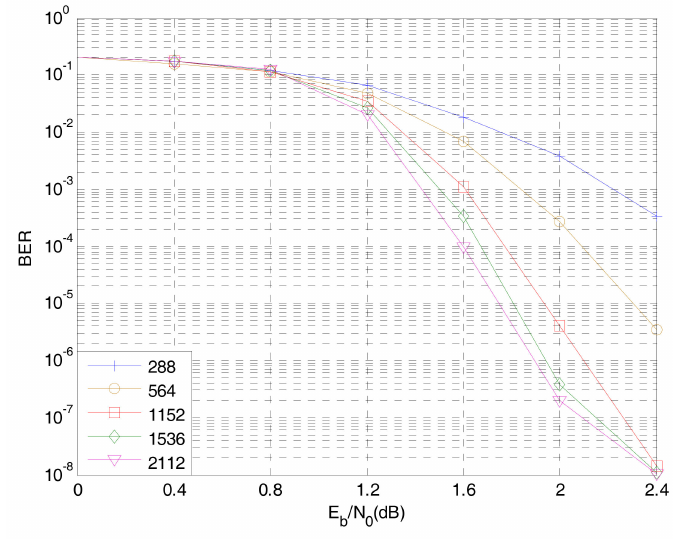
Figure 10. The influence of information bit length on the performance of 8-ary LDPC-CPM